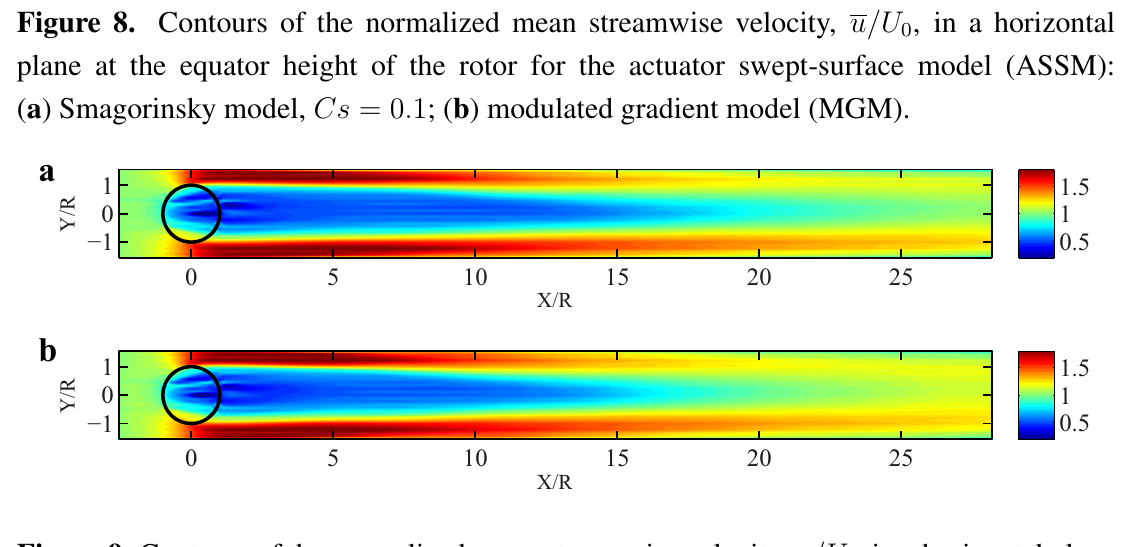
, in a horizontal 0